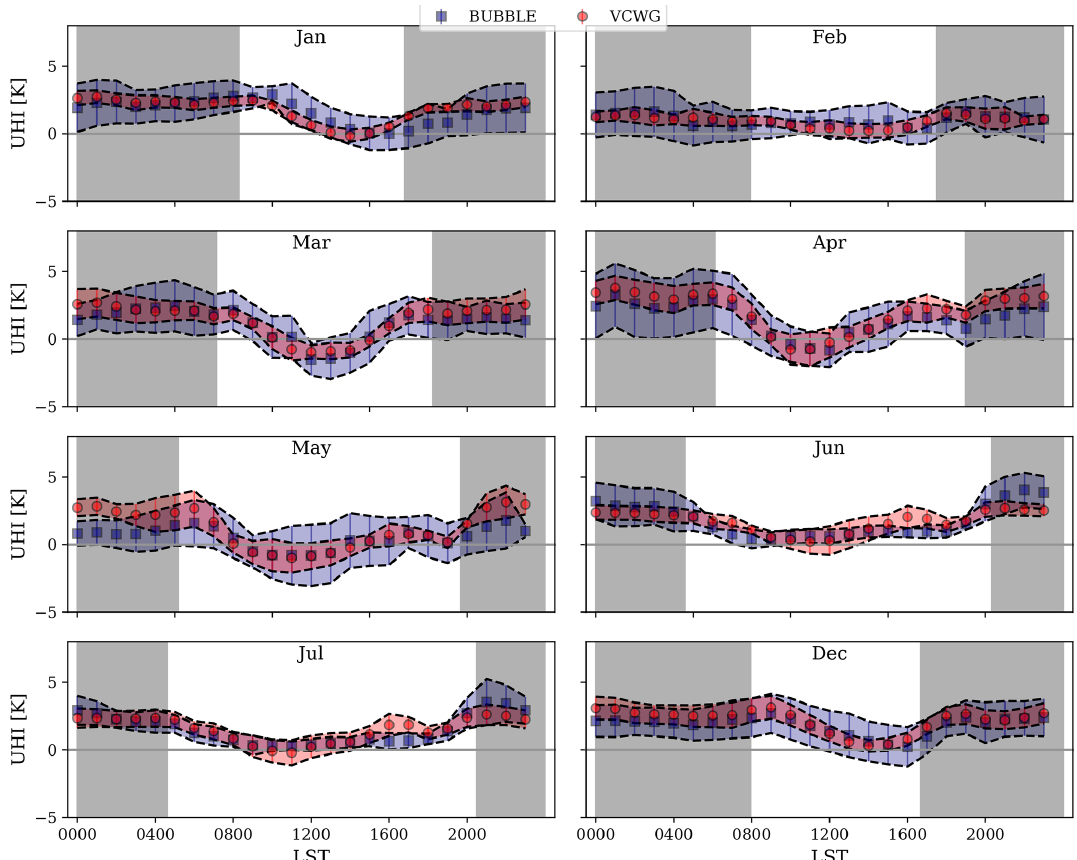
Figure 8. Hourly mean and standard deviation (band) of UHI (K) in each month for the observed (BUBBLE) and predicted (VCWG) values; nighttime is indicated by shaded regions. Times are in local standard time (LST). Table 5. Bias (K), RMSE (K), and R 2 (–) for VCWG predictions of UHI (K) against the BUBBLE observations for different months. Statistic Dec Jan Feb Mar Apr May Jun Jul Average Bias (K)